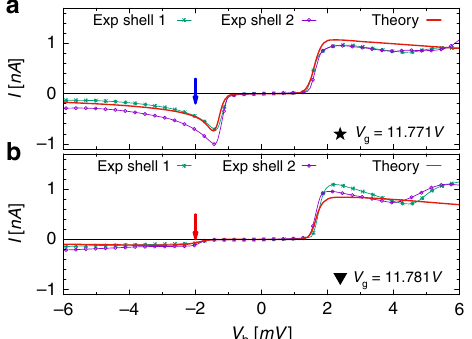
Fig. 4 I − V characteristics in the presence of dark states . a , b Experimental current-bias characteristics (data points with solid guiding lines) around the 0 ↔ 1 resonance for shell 1 at voltages V g = 11.771V ( a ) and V g = 11.781 V ( b ) are compared to numerical results (thicker solid lines). These gate voltages correspond to the vertical dashed lines in Fig. 3c with the associated star and triangle labels. The behavior at positive voltages is similar. At negative bias, however, one observes a pronounced negative differential conductance in panel ( a ) and almost vanishing current in panel ( b ). The more effective coherent population trapping in ( b ) indicates a vanishing precession between the dark and the coupled state; see Fig. 1a.